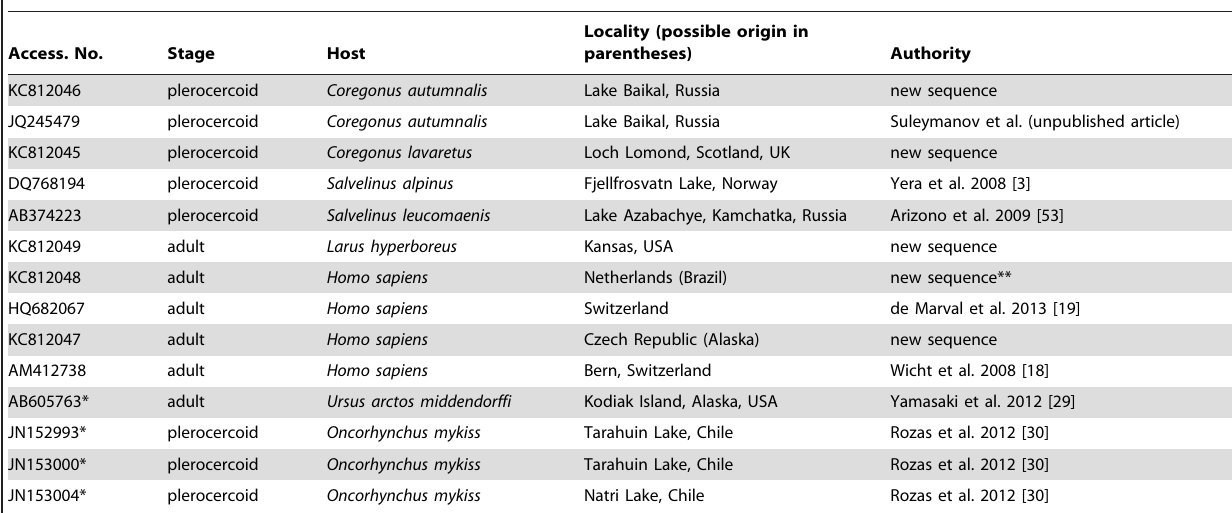
Table 1. Sequences of Diphyllobothrium dendriticum used in phylogenetic analysis (Figure 1).